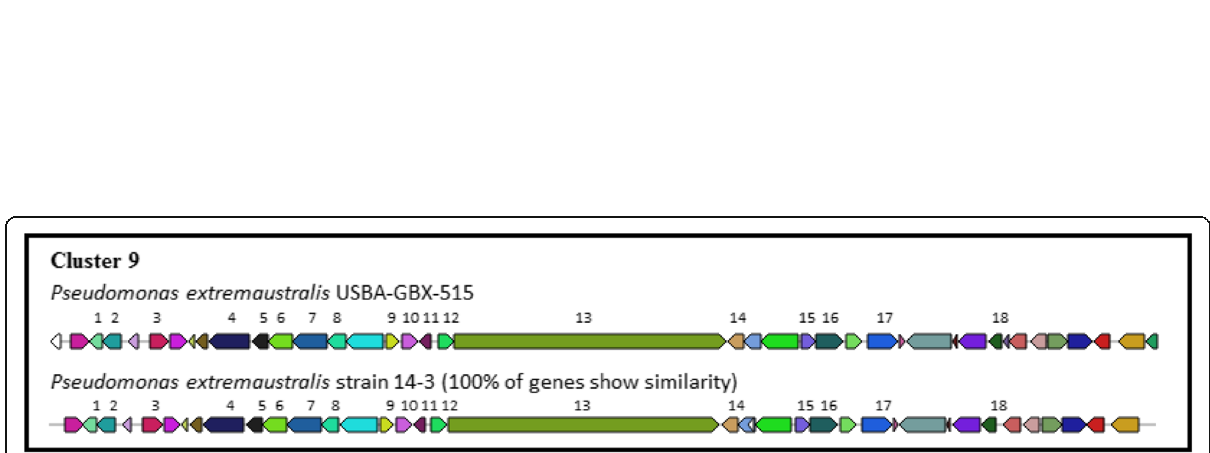
Fig. 12 Genetic map of Pyoverdine biosynthetic gene cluster 9 detected by AntiSMASH. The genes were designated by colors. Same color means equal genes in different strains; not colored means other genes. 1. two-component system response regulator; 2. two-component system response regulator; 3. chemotaxis signal transduction system response regulator CheV; 4. geranyl-CoA carboxylase subunit alpha; 5. Isohexenylglutaconyl-Coa hydratase; 6. citronellyl-CoA dehydrogenase; 7. geranyl-CoA carboxylase subunit beta; 8. citronellol- dehydrogenase; 9. atu genes repressor; 10. amino acid ABC trans- porter substrate-binding protein; 11. extracytoplasmic-function sigma-70 factor; 12. pyoverdine biosynthesis protein PvdG; 13. Peptide synthase; 14. thiol:di- sulfide interchange protein DsbG; 15. two-component sensor histidine kinase; 16. two-component response regulator; 17. diaminobutyrate – 2-oxoglutarate aminotransferase; 18. pseudouridine